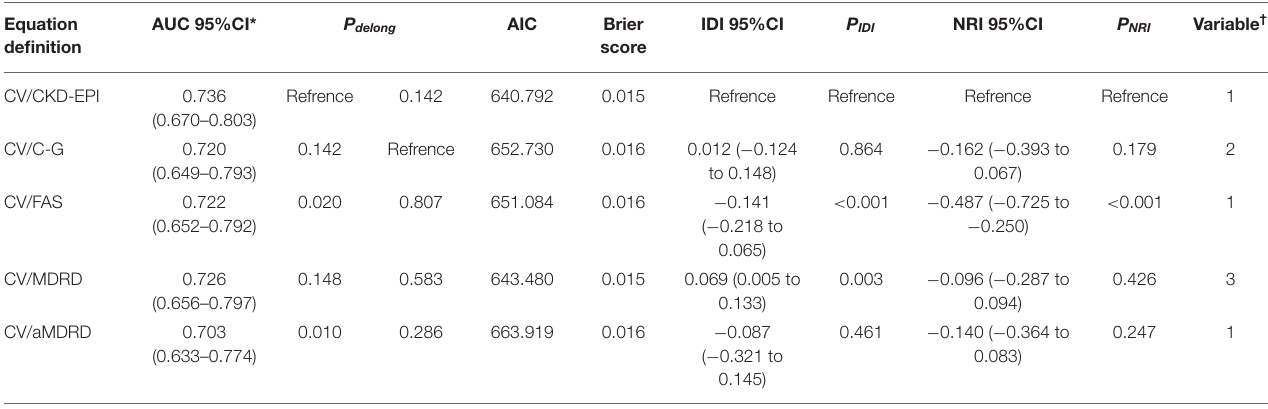
TABLE 2 | Comparison of the five equations of CIN using IDI and NRI. Equation